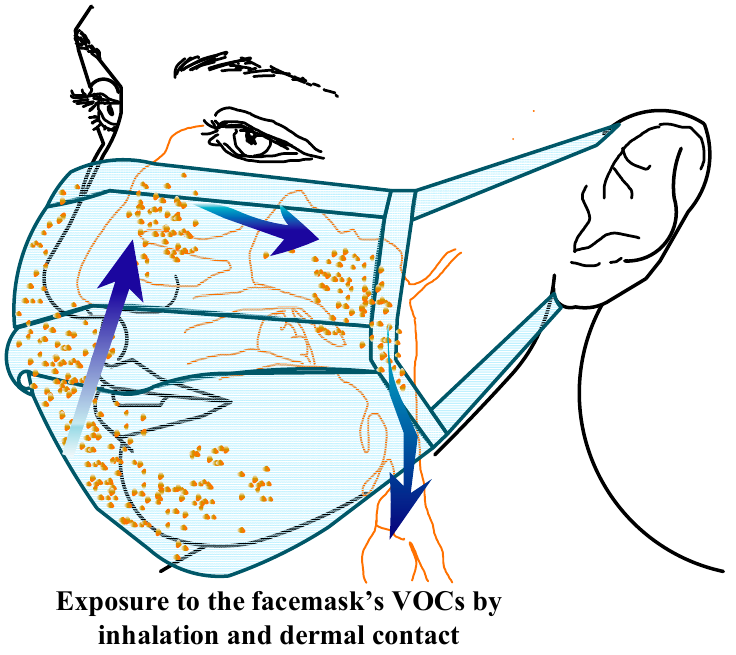
Figure 1. Exposure to volatile organic compounds present in the facemask materials, by inhalation and dermal contact (authors own creation).